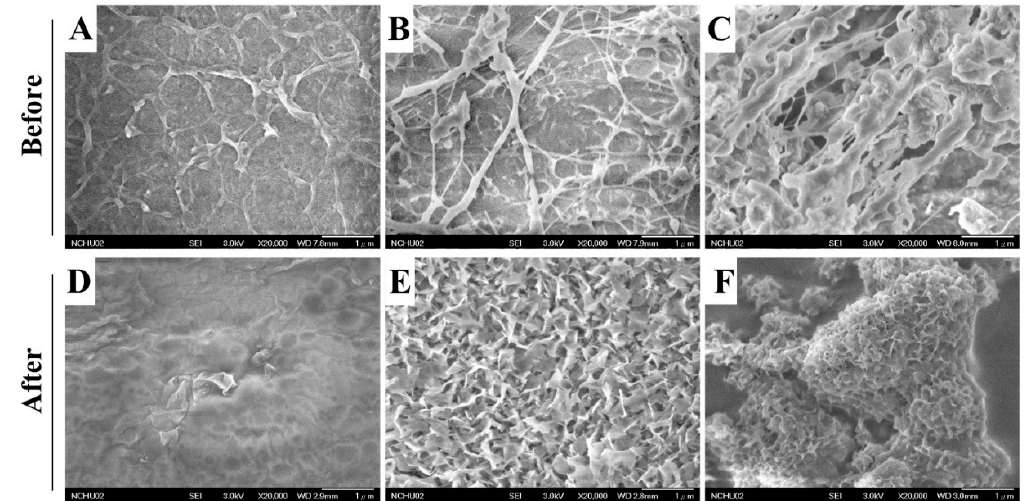
Figure 2. Surface morphology of ( A , D ) PVA, ( B , E ) PVA-HA nanocomposites, and ( C , F ) PVA-CoHA nanocomposites before and after immersion in SBF for 7 days.